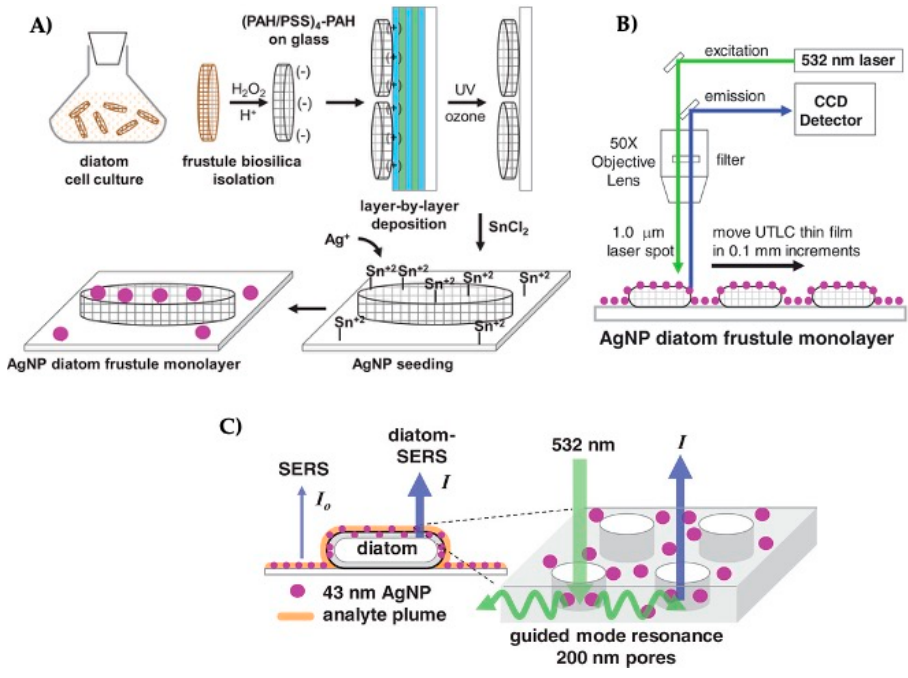
Figure 4. ( A ) Fabrication of the AgNPs–diatom frustule biosilica monolayer on glass. ( B ) Configuration of micro-Raman laser for scanning ultra-thin layer chromatography film embedded with diatom for surface enhancement Raman scattering (SERS). ( C ) Schematic representation of SERS signal intensity of separated analyte plume around AgNPs–diatom frustule monolayer versus AgNPs on the glass, illustrating the guided-mode resonance effect. Reproduced and adapted from Reference [75], copyright (2020), with permission from John Wiley and Sons.